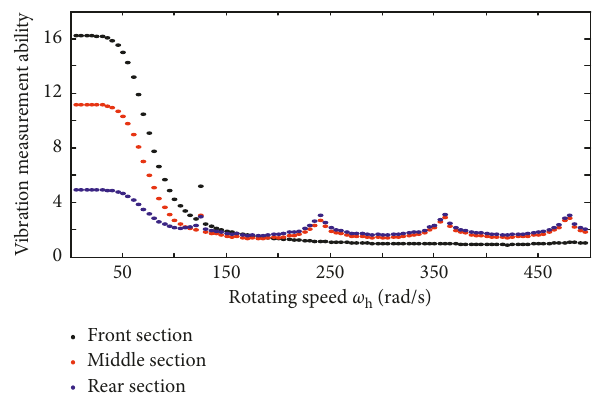
Figure 8: Vibration measurement ability C with varying rotating speed of high-pressure rotor ω h : front section (black), middle section (red), and rear section